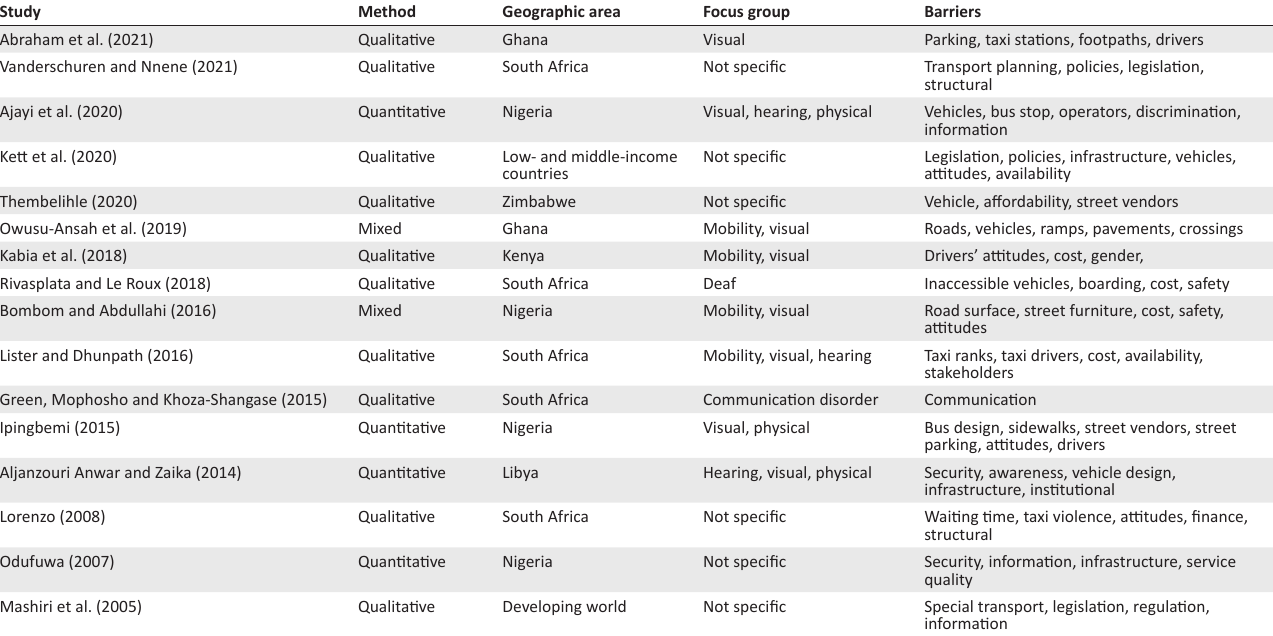
TABLE 1: An overview of included studies